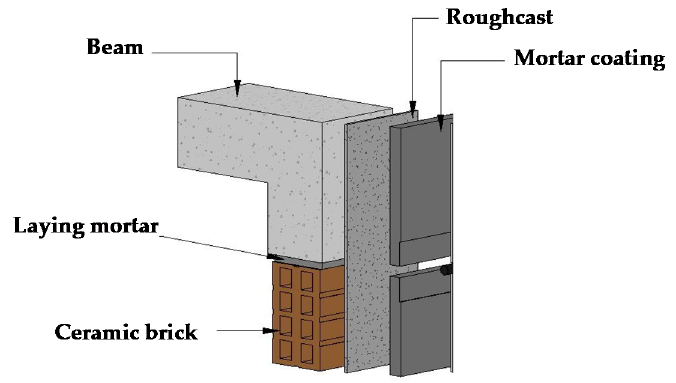
Figure 2. Details of the coating constitution.